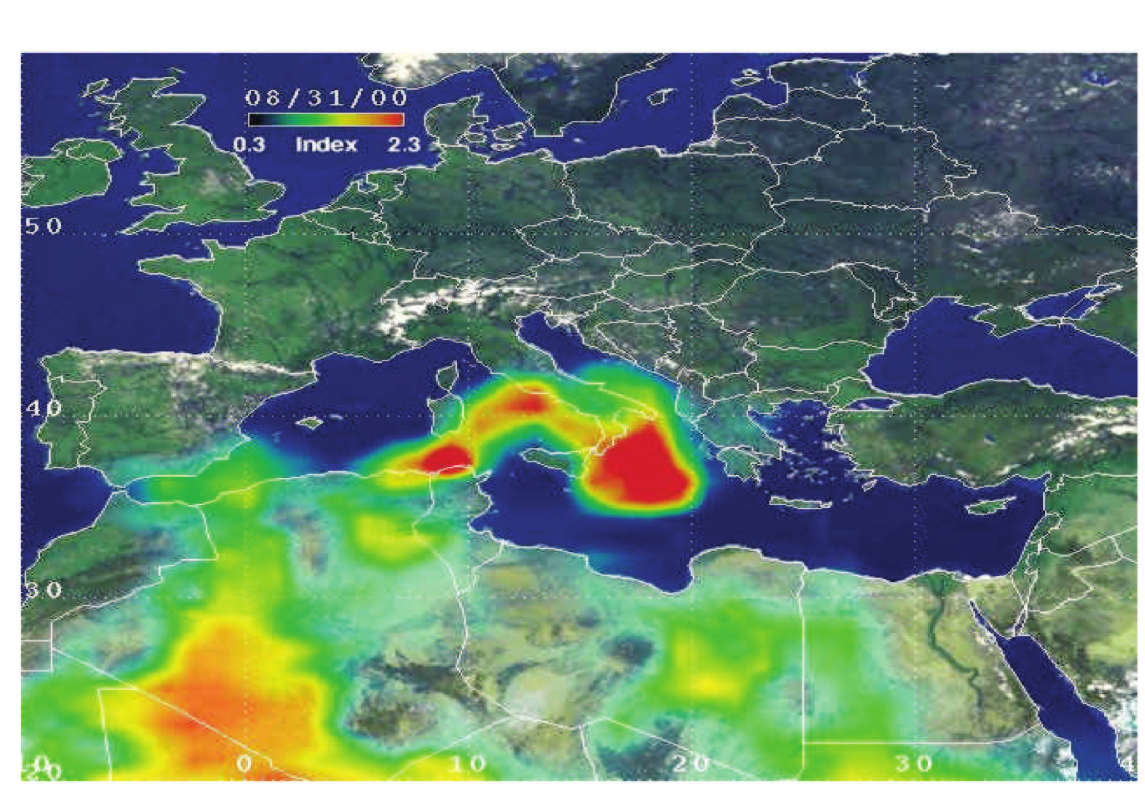
Fig. 5. The EP/TOMS aerosol index data for 31 August 2000.